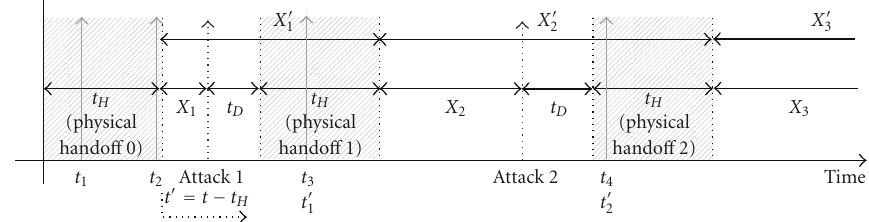
Figure 3: Analytical model for the Lion